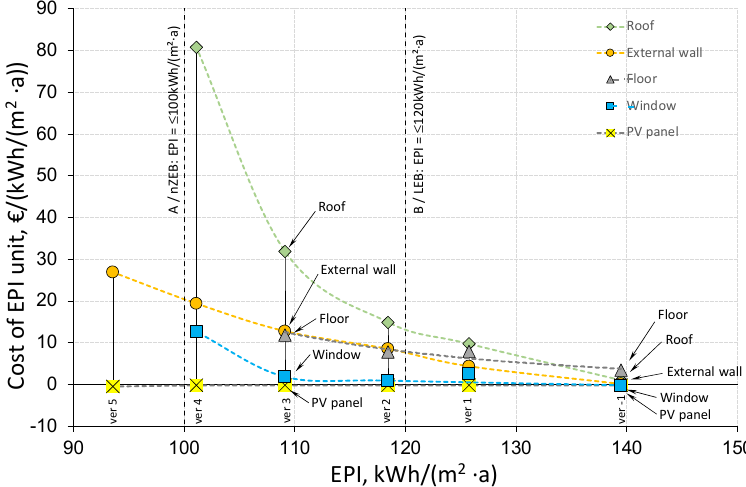
Figure 5. Additional cost of a one-step improvement in different insulation measures at different EPI levels.